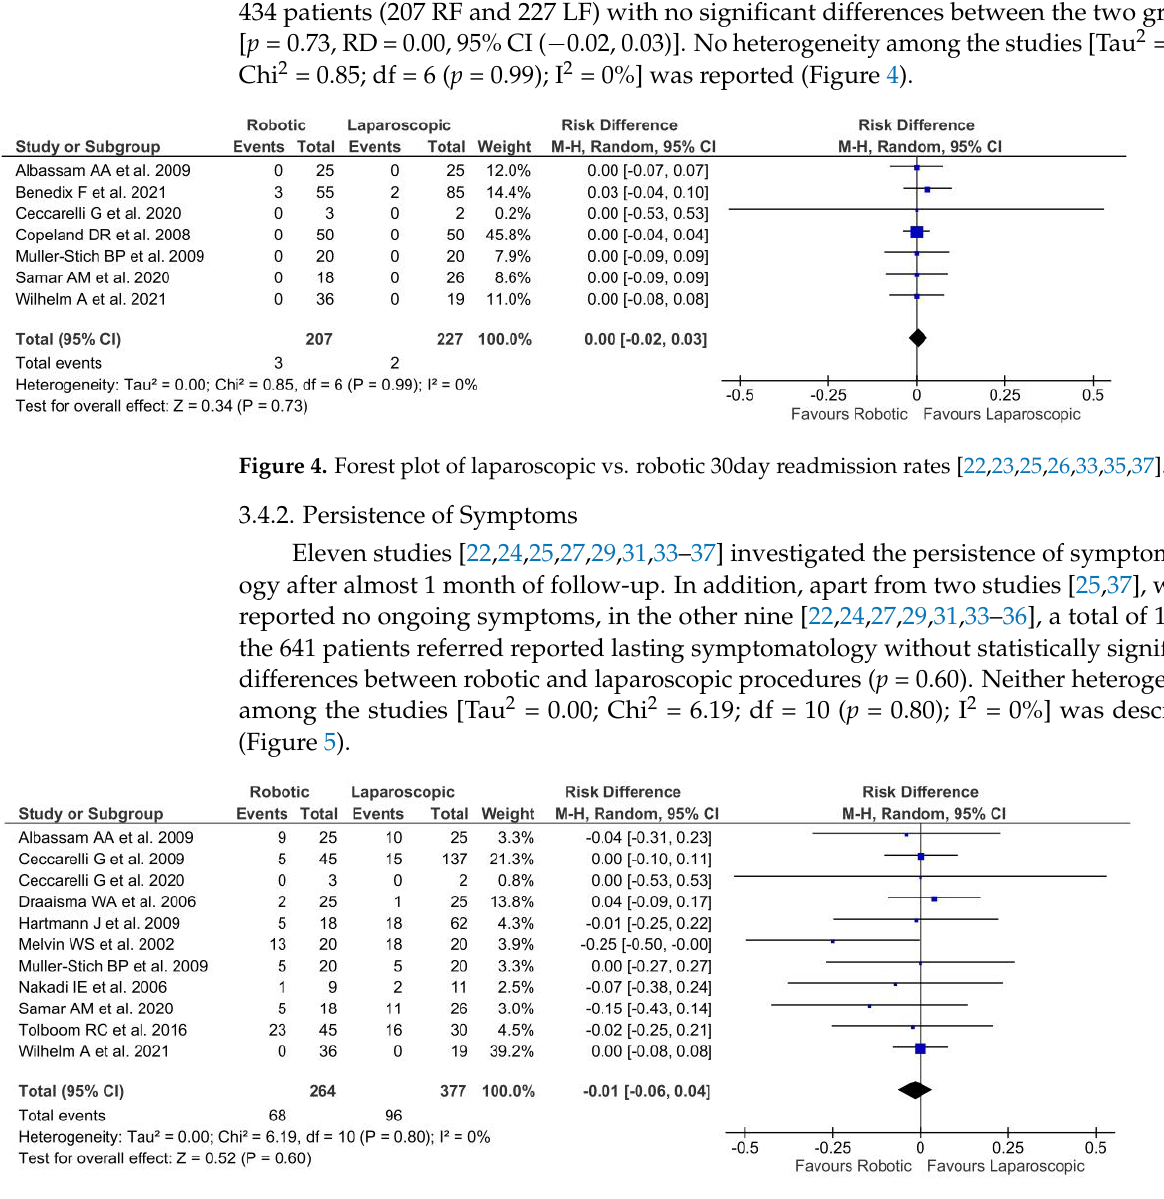
Figure 5. Forest plot of laparoscopic vs. robotic persistence of